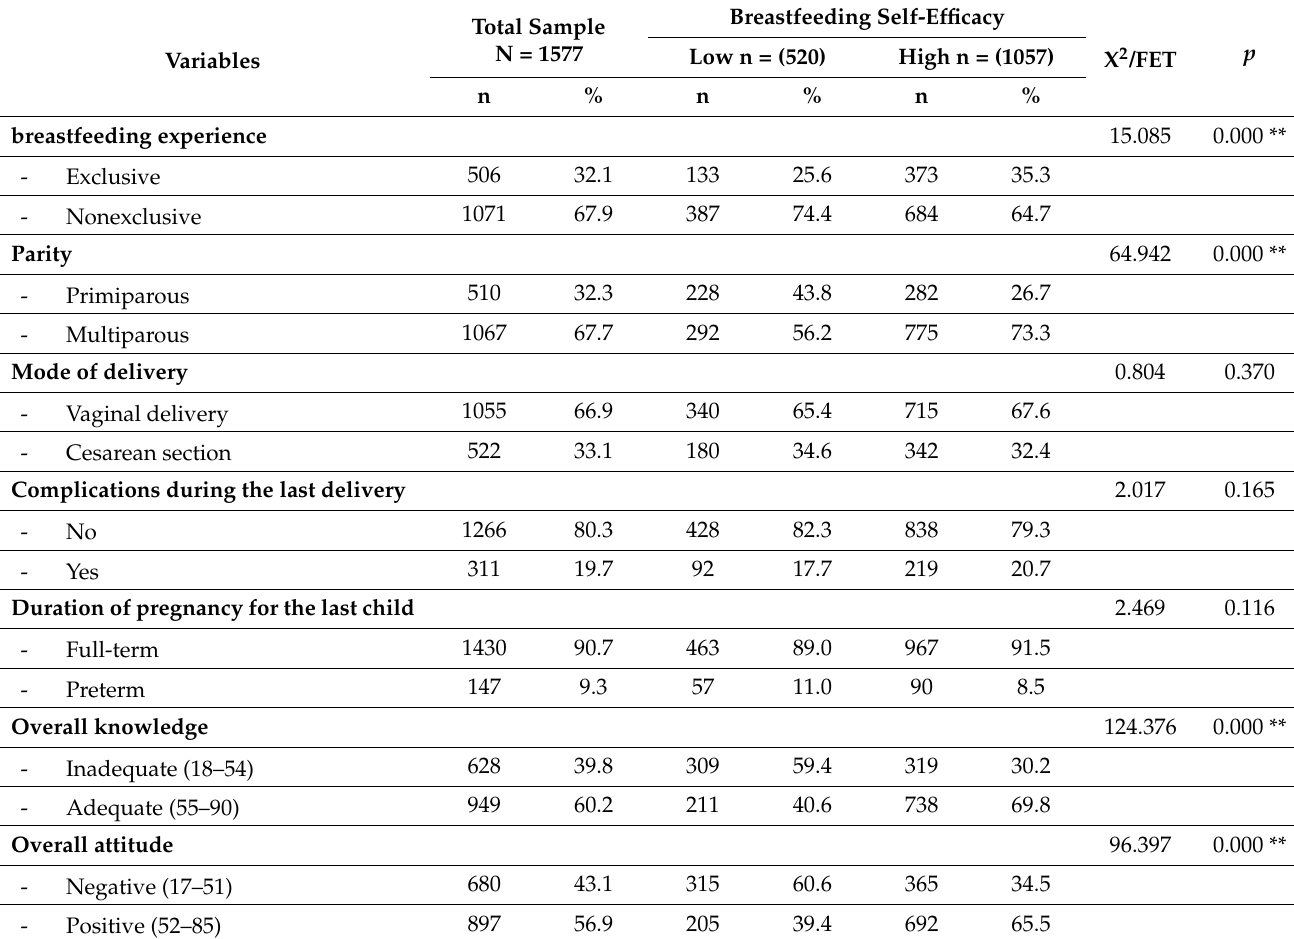
Table 2. Frequency distribution of nursing mothers by breastfeeding experience, obstetric history, overall breastfeeding knowledge, attitude, and self-efficacy